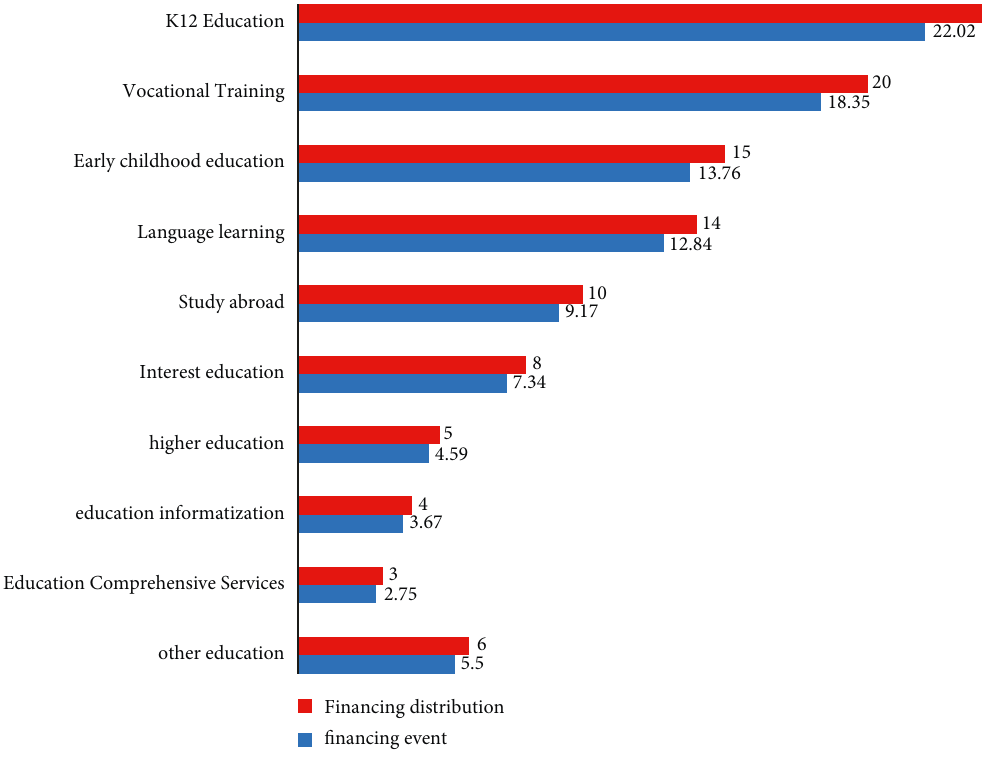
Figure 1: Development of Internet +education